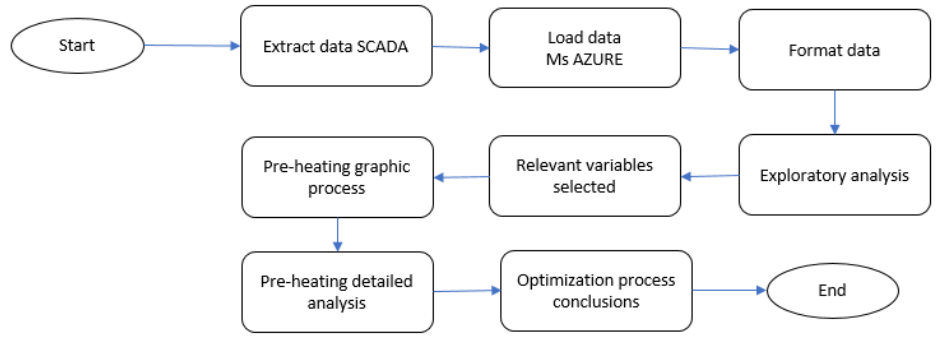
Figure 2. Proposed methodology.